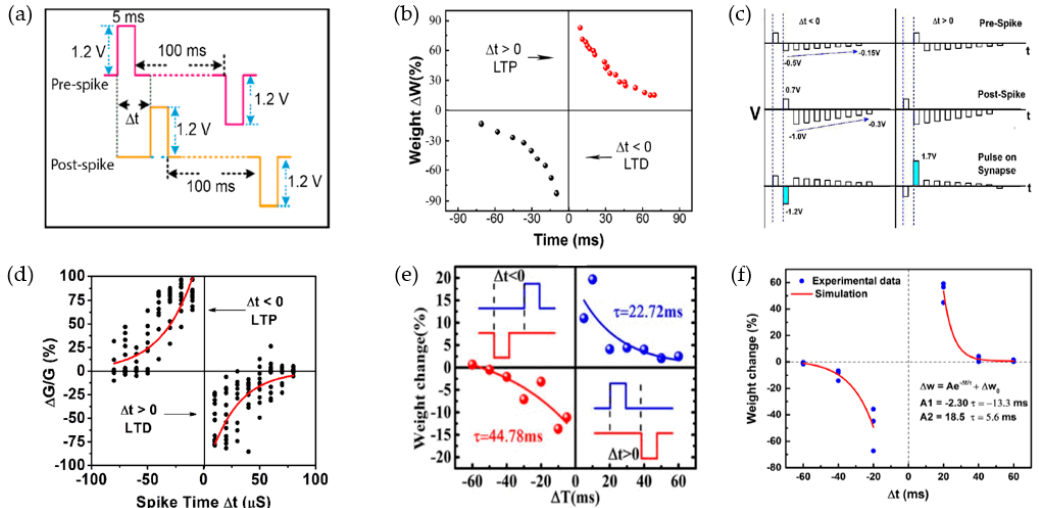
Figure 15. ( a ) Implementing programming pulses and ( b ) STDP behavior of Ag/SiO x :Ag/TiO x /p ++ -Si RRAM device, reproduced from [155], with permission from Springer Nature, 2020. ( c ) Applied pre/post-spikes with sequences and ( d ) STDP characteristics of TaN/HfO 2 /Al 2 O 3 /ITO RRAM device, reproduced from [20], with permission from Elsevier, 2020. ( e ) STDP results with pulse interval modulation of pre- and post-synaptic spiking for PEDOT:PSS-based RRAM device, reproduced from [163], with permission from MDPI (Basel, Switzerland), 2018. ( f ) Experimental and fitting results of STDP behaviors for Ag/SrTiO 3 /RGO/FTO RRAM device, reproduced from [166], with permission from Elsevier, 2018.